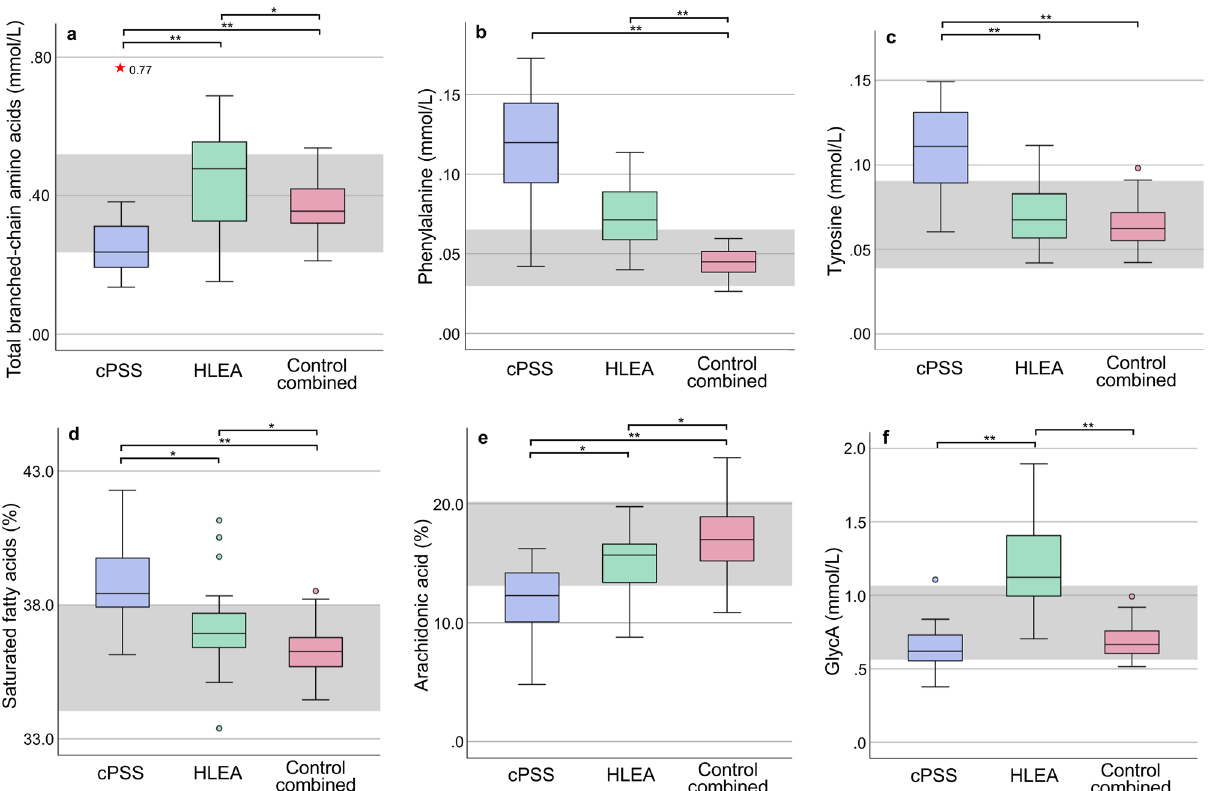
Figure 4. Concentrations (mmol/L) of total branched-chain amino acids (BCAAs) ( a ), phenylalanine ( b ), tyrosine ( c ), percentage of saturated fatty acids ( d ), percentage of arachidonic acid ( e ), and concentrations (mmol/L) of glycoprotein acetyls (GlycA) ( f ) in serum samples from dogs with cPSS (n = 24), HLEA (n = 25), and the combined Control group (n = 64). Boxes indicate the lower to upper quartile (25th–75th percentile) and median value. Whiskers extend to minimum and maximum values. Outliers are shown as individual open circles or red stars. Grey boxes indicate reference intervals. Lines above figures reflect significant differences between specific groups (* p < 0.05; ** p <